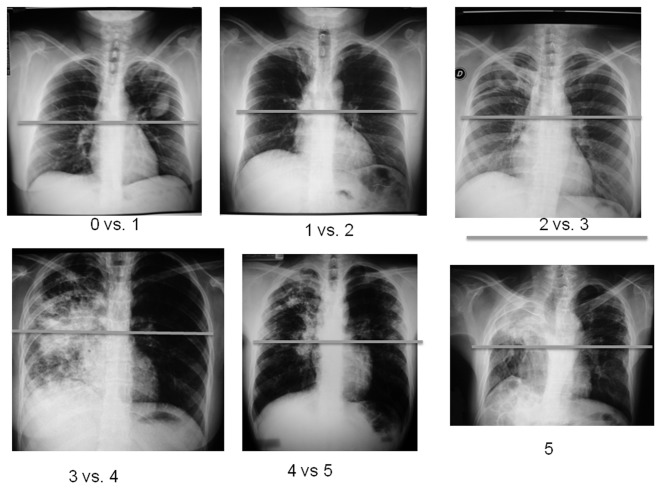
Representative example radiographs of quadrants for each score, according to the degree of radiographic abnormality using the same quadrant (upper left).The radiographs are from different patients from the study.